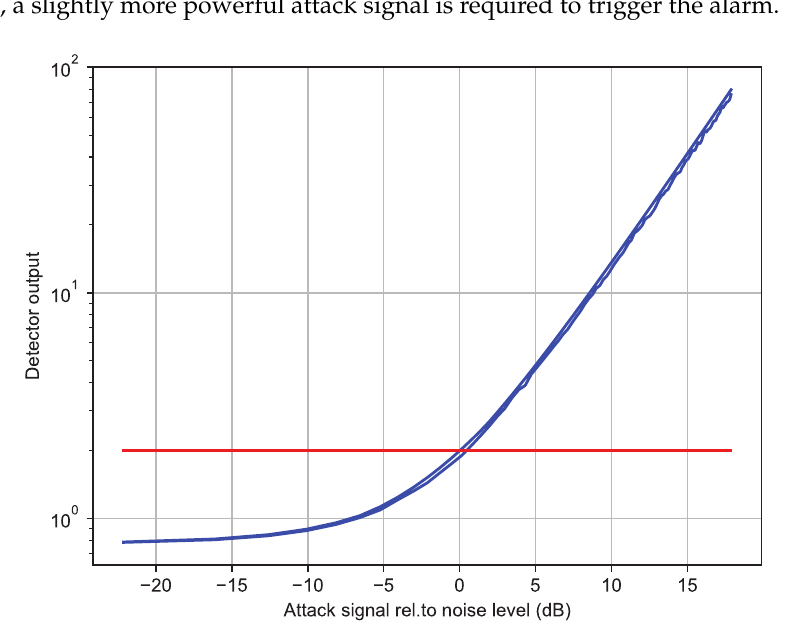
Figure 16. No target case. The horizontal orange colored line is the detection